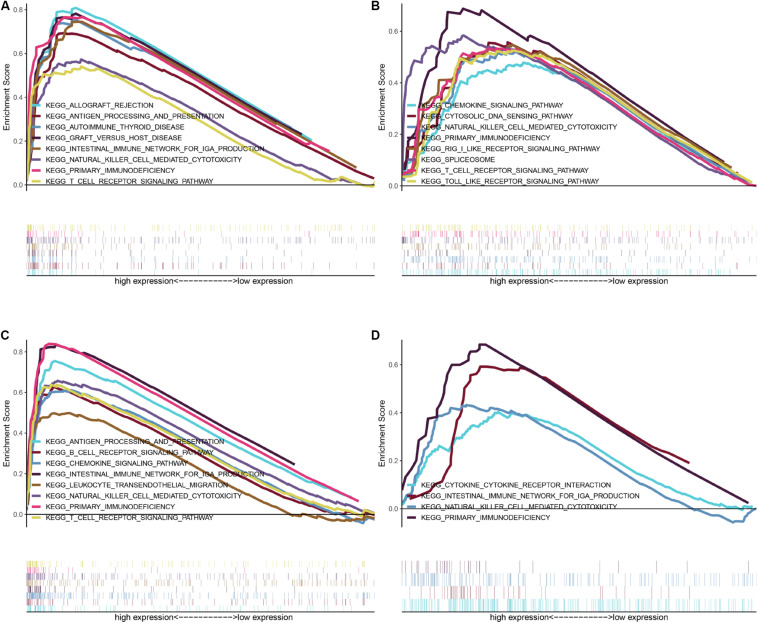
GSEA of KEGG pathway gene sets in CEP55 (A), IFI44 (B), NCF4 (C), and TCIRG1 (D) high versus low samples from TCGA database. Normalized enrichment score (NES) is shown in each plot.